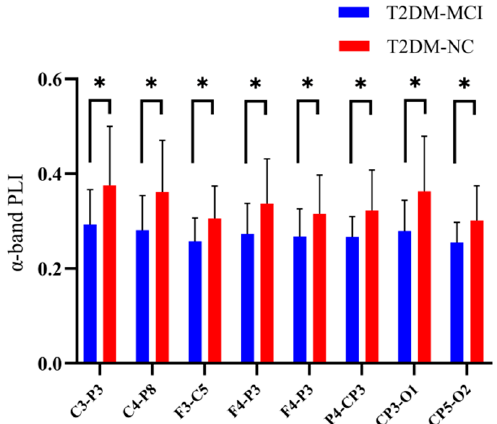
Figure 2. The phase lag index of eight specific electrode pairs in the alpha band between the T2DM- MCI and T2DM-NC groups. The T2DM-MCI group and T2DM-NC group are shown in blue and green boxes, respectively. Error bars are standard deviations. * p < 0.05.